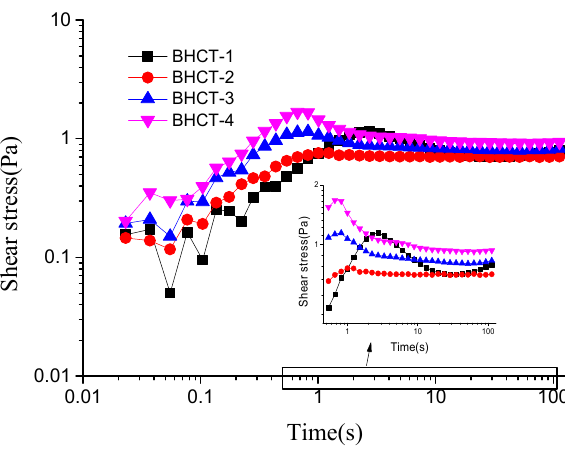
Figure 18. Time-dependent apparent shear stress of composite gels under di ff erent crosslinker